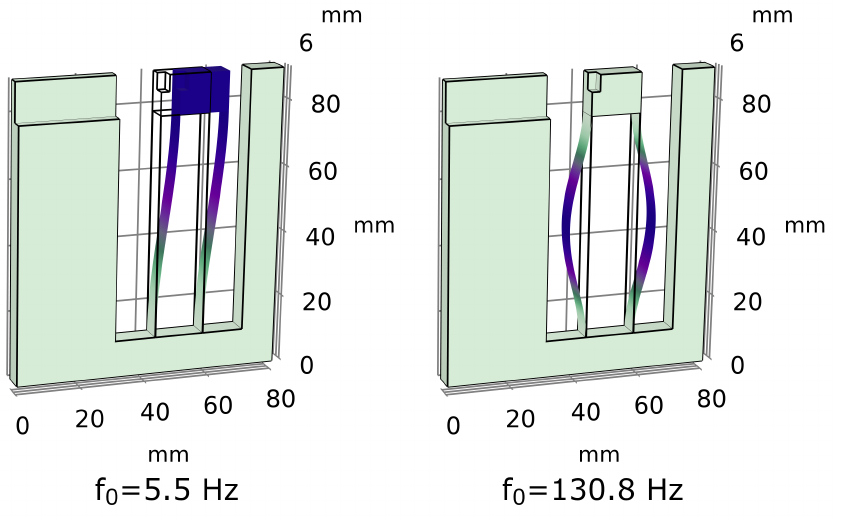
Figure 2. The first two eigenmodes of our 5Hz resonator modeled in COMSOL. Note that the second mode is larger than the first by a factor of more than 10. Having higher-order modes that are substantially higher than the first mode is desired for minimizing the cross talk between modes observed in measurements.